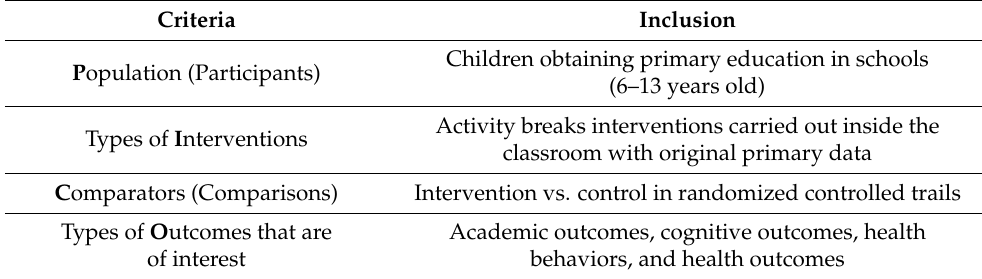
Table 1. Criteria for Eligible